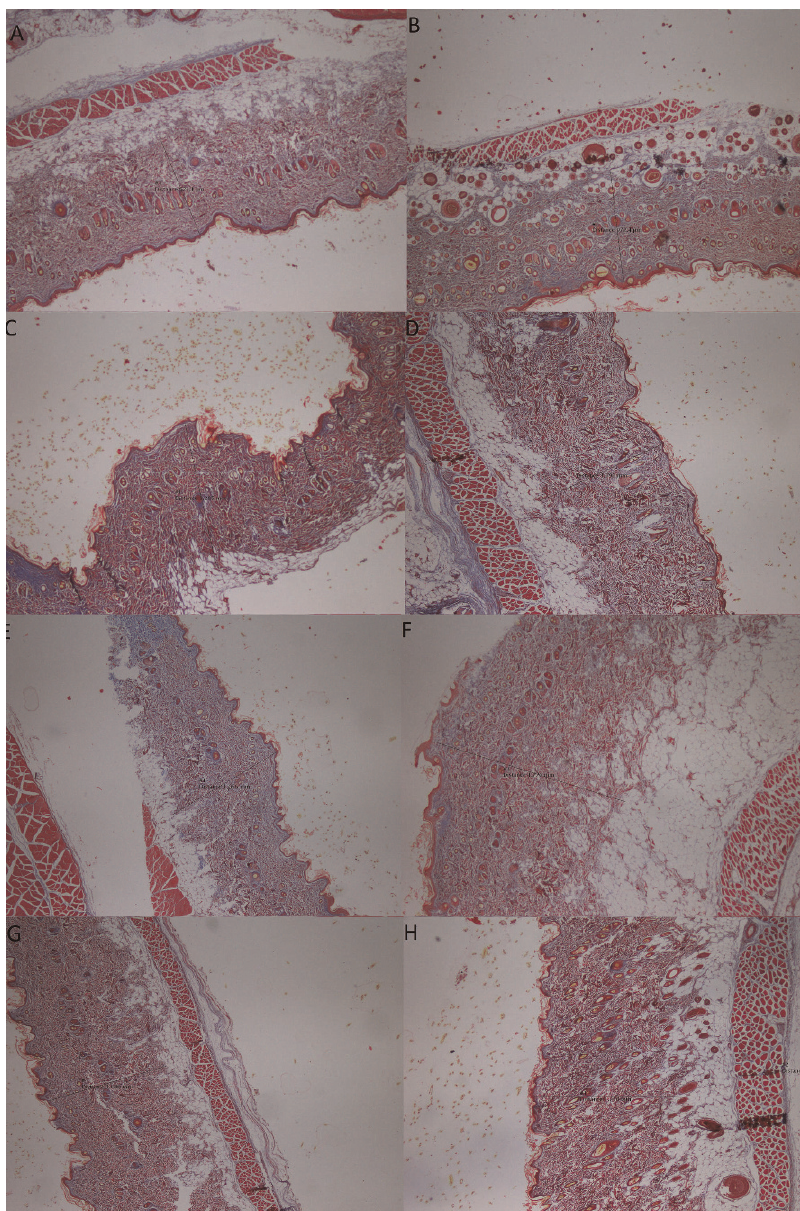
Figure 3 - Histological evaluation of Masson’s trichrome-stained sections of skin biopsies from the CMC-free group (A), the 0.5% CMC- plus group (B), the group treated with the n-hexane extract at a dose of 100 mg/kg (C), the group treated with the n-hexane extract at a dose of 200 mg/kg (D), the group treated with the ethyl acetate extract at a dose of 100 mg/kg (E), the group treated with the ethyl acetate extract at a dose of 200 mg/kg (F), the group treated with the ethanol extract at a dose of 100 mg/kg (G), and the group treated with the ethanol extract at a dose of 200